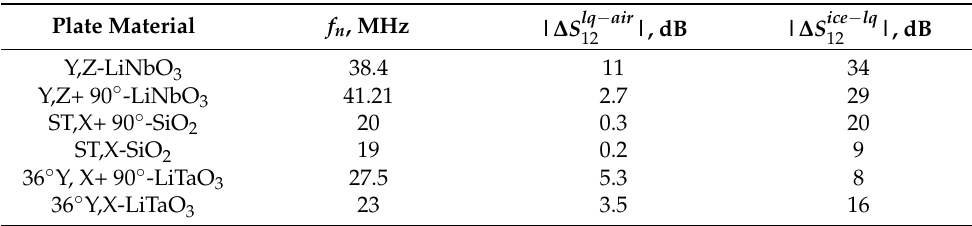
Figure 4. Insertion loss S 12 of the delay line implemented on the Y,Z-LiNbO 3 plate with a normalized thickness of h/ λ = 1.67, as measured by the network analyzer in air at 20 ◦ C (thin solid), with water loading at 20 ◦ C (thick solid), and ice loading at − 15 ◦ C (dotted). The position of the water (ice) sample on the plate is shown in Figure 2a. The velocity and electromechanical coupling coefficient of the mode at 38.4 MHz are V n = 11,563 m/s and k 2 n = 1.12%. Table 1. The modes with the largest acoustic wave ice responses measured in different plates with the same normalized thickness h / λ = 1.67.